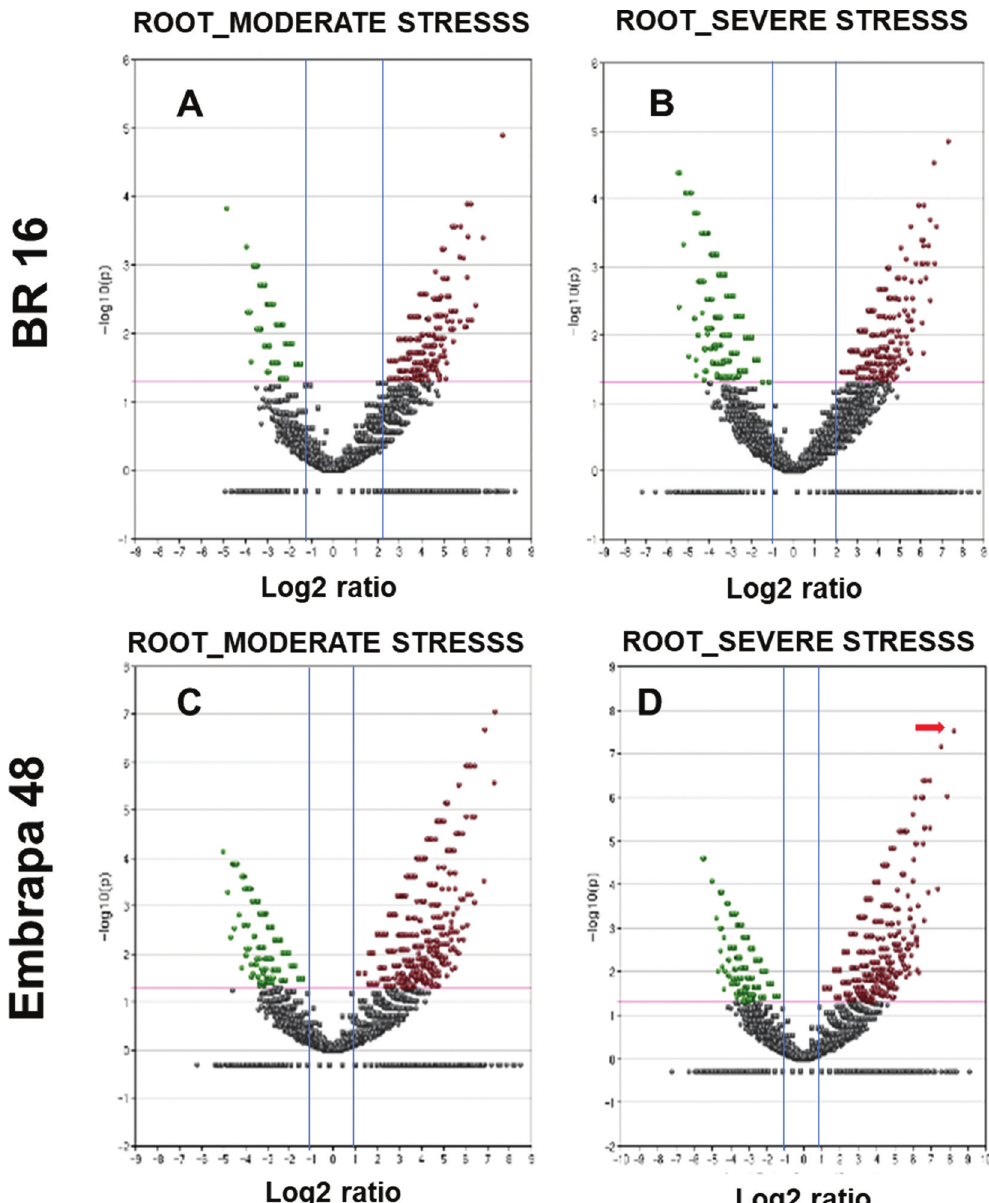
Figure 3 - Volcano plots. Expression data (fold-change) were plotted using log2 scale (x-axis) and -log 10 transformation of the p -value (y-axis). Datasets were filtered to remove genes with low expression levels (blue line on the x-axis (cid:5) 1 and -1 and red lines on the y-axis); the red line is the threshold applied to delimit a significance cut off ( p < 0.01). The red points were used to represent up-regulated genes and green points down-regulated genes. The red ar- rows indicate the highest expression of the same genes for (A) roots from BR 16 in moderate stress library; (B) roots from BR 16 in severe stress library); (C) roots from Embrapa 48 in moderate stress library); (D) roots from Embrapa 48 in severe stress